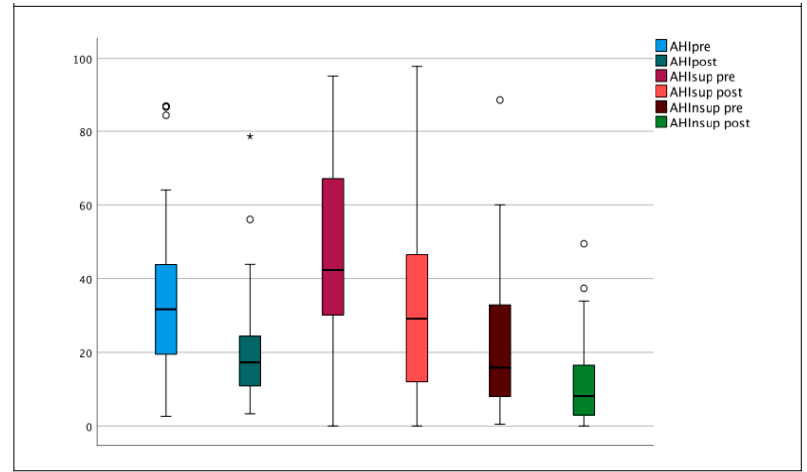
Figure 1. Boxplot showing postoperative improvement of AHI, AHI supine, and AHI non supine. AHI (Apnea Hypopnea Index), AHI sup (Apnea Hypopnea Index supine), AHI nsup (Apnea Hypopnea Index non-supine). Pre (Pre-operative), Post (Post-operative). Asterisk and circles represent outliers.